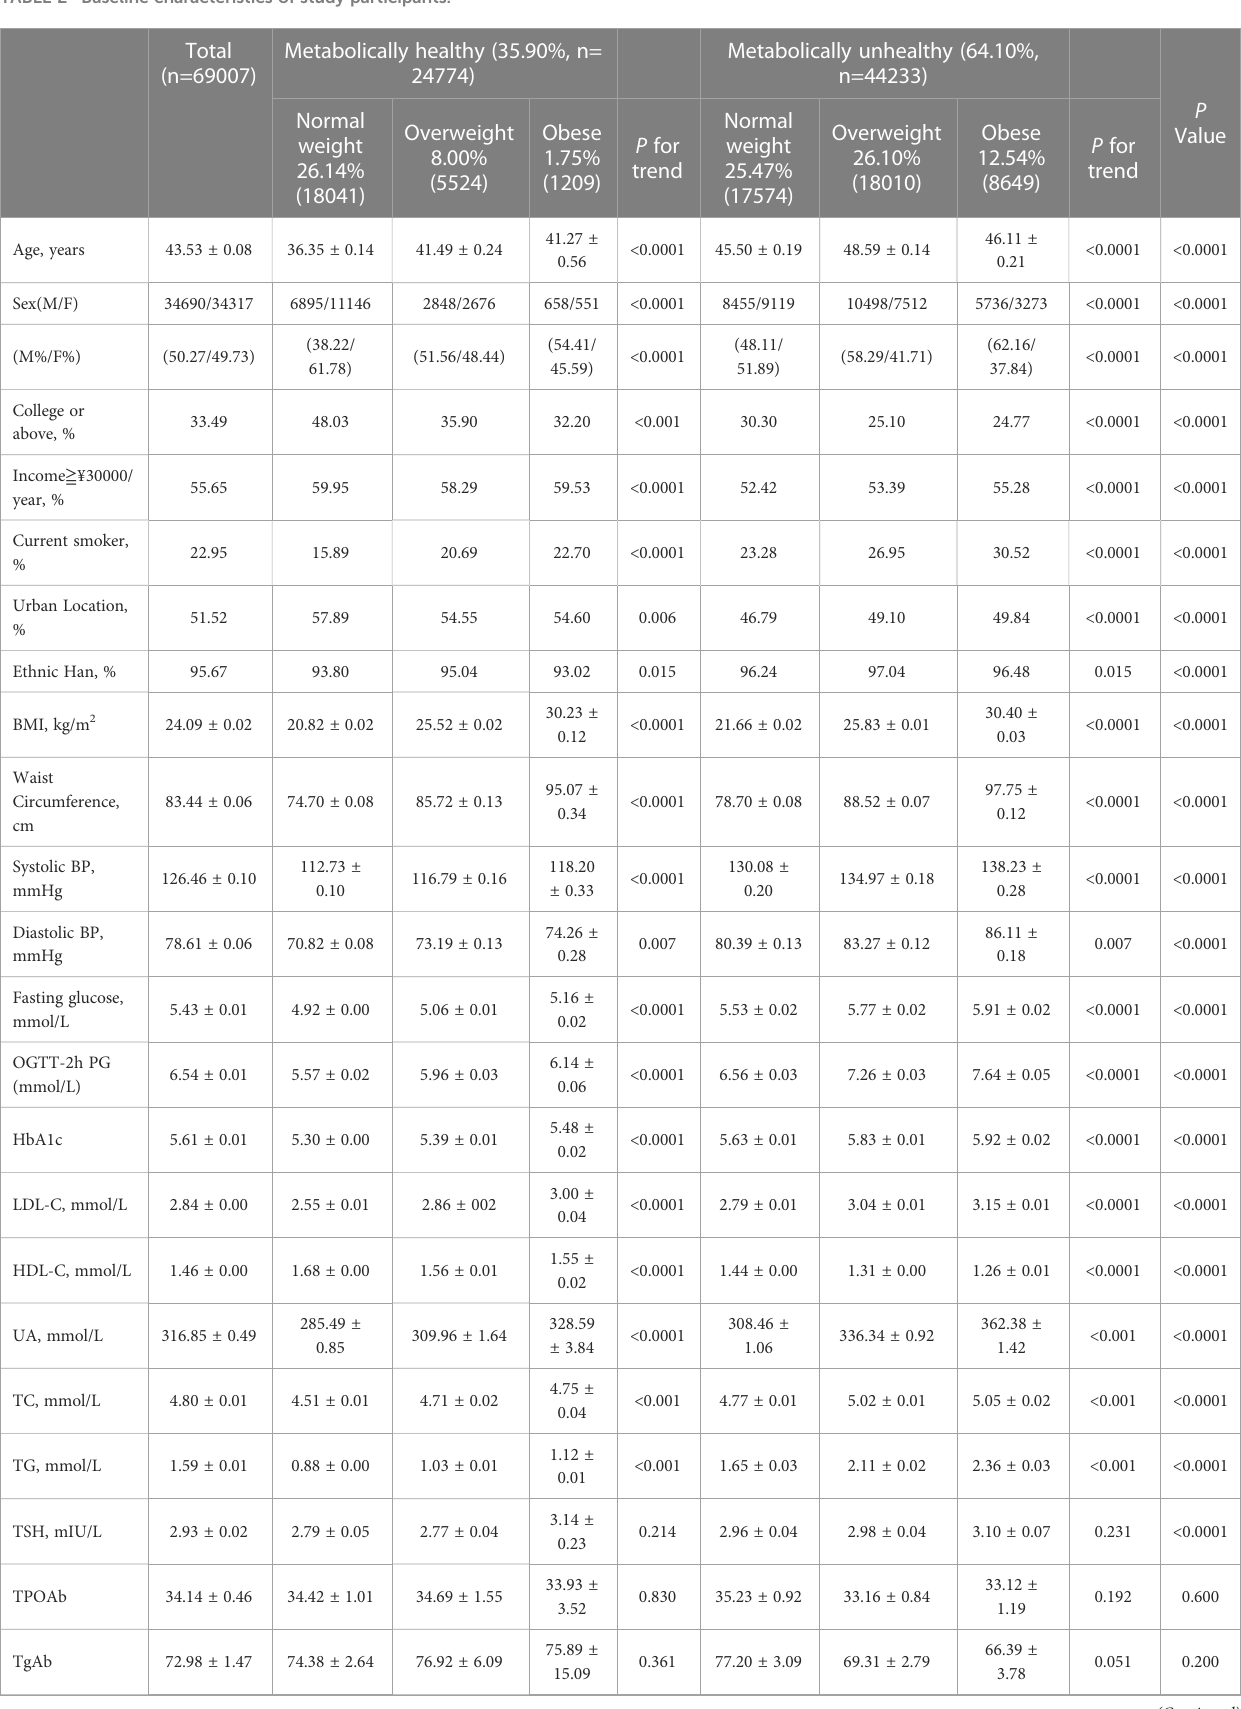
TABLE 2 Baseline characteristics of study